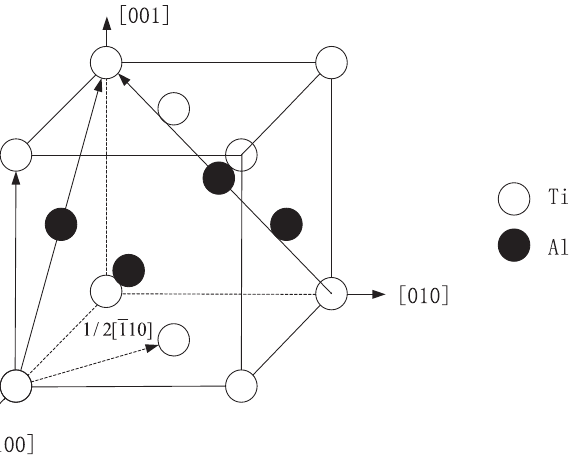
Figure 1: L1 0 structure of γ -TiAl.